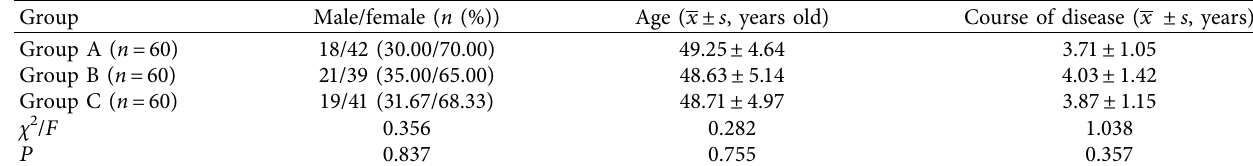
Table 1: Comparison of the distribution of the 3 groups of general